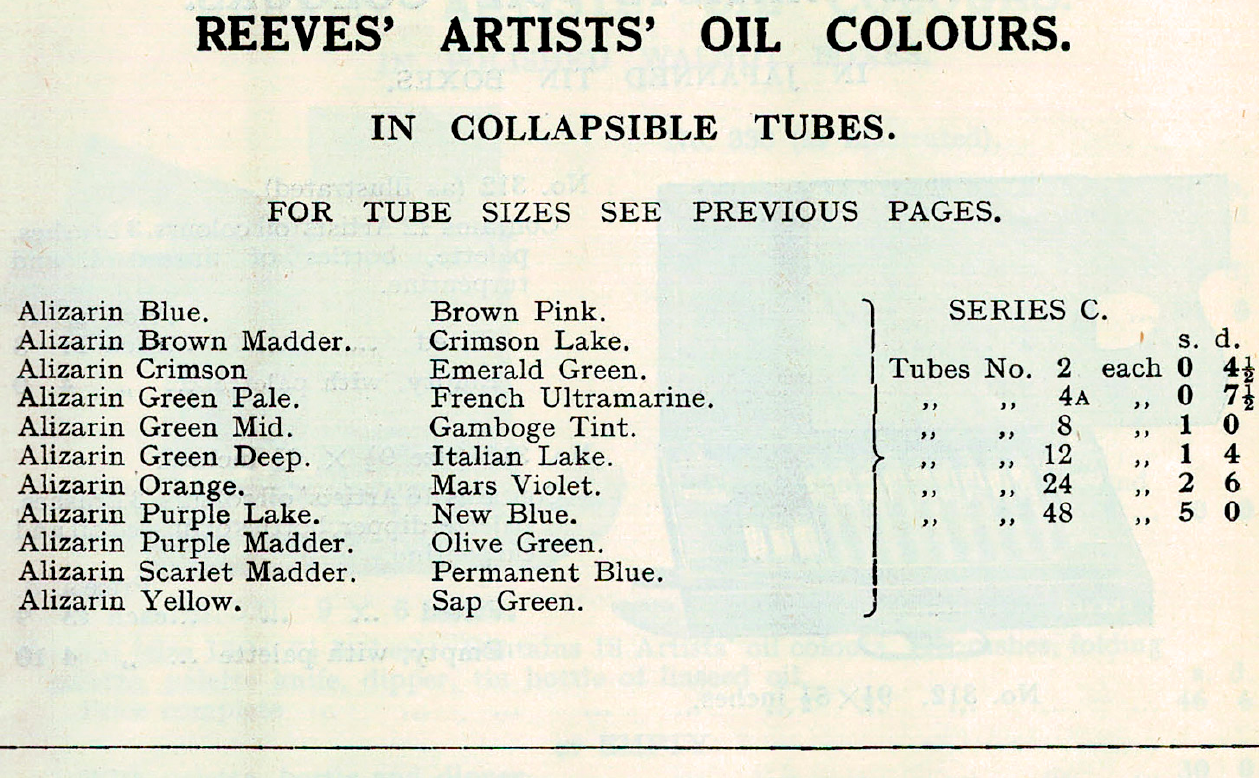
Figure A2. Selected oil colours, listed in the catalogue of R&S from 1934.